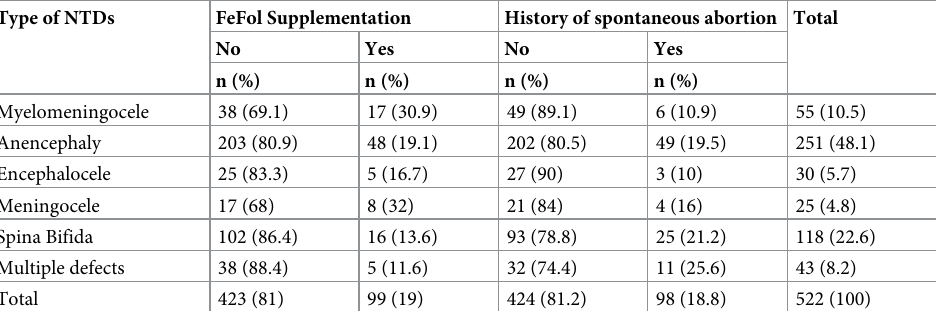
Table 8. Type of NTDs by FeFol supplementation and history of spontaneous abortion, Eastern Ethiopia data from